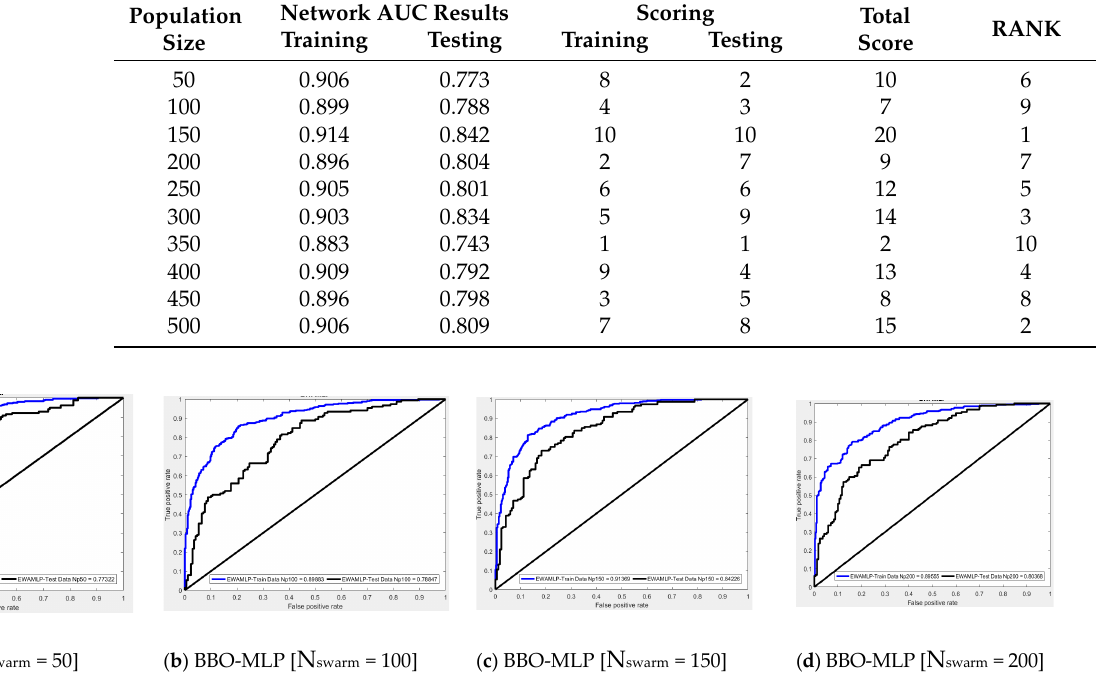
Figure 8. The variation of mean squared error as a function of iterations was acquired as from sug- gested BSAMLP architectures for forecasting flood vulnerability mapping. Table 3. The Results of AUC for different BBOMLP proposed structure in predicting the landslide susceptibility mapping.